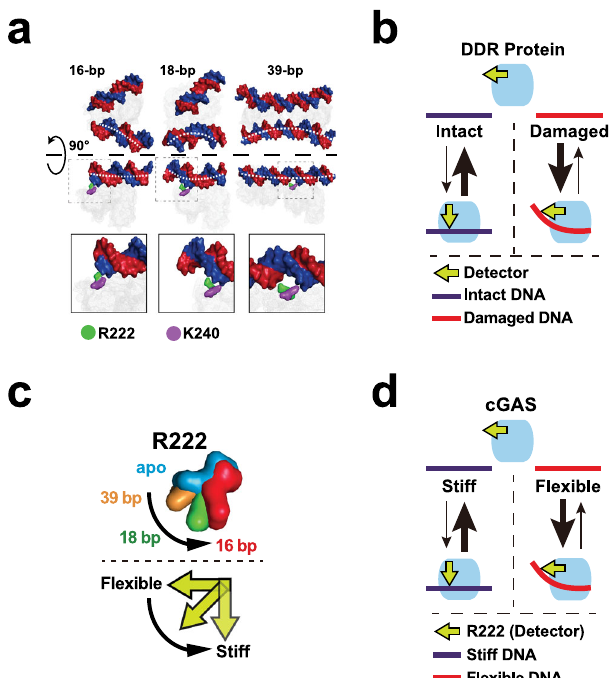
Fig. 1 | Schematic showing that DNA mechanical fl exibility controls cGAS activation. a Schematic showing that DNA strands are curved in the 16- (PDB 4K96), 18- (PDB 4LEZ), and 39bp (PDB 5N6I) DNA – cGAS atomic models. Notably, the conformation of cGAS R222 DNA-binding residue is considerably changed. R222 and K240 bind the same single strand of DNA (blue strand) in 18- and 16bp atomic models, while R222 and K240 separately bind the distinct single strands of DNA in 39bp atomic model. DNA and residues are shown by surface representa- tions.Blueandred:DNA;Green:R222;Purple:K240. b SchematicshowingthatDDR protein classically changes the conformation of detector to deform DNA to inte- grate DFC. It isenergeticallyunfavourable to curve the intact/stiff DNA. Hence, the intact/stiff and damaged/ fl exible DNAs form unstable and stable protein – DNA complexes, respectively. c Upper panel: Superposition analyses of R222 in apo (blue) (PDB 4K8V), 16- (red), 18- (green) and 39bp (orange) DNA – cGAS atomic models showing that the R222 conformation is changed with the DNA length. The sidechainofR222inapocGASatomicmodelisapproximatelyperpendiculartothe side chainofR222inthe 16 and 18bp DNA – cGASatomicmodels. R222isshownby surface models. Low panel: Schematic showing that the conformation of R222 (yellow arrow) might be changed with DNA- fl exibility, which is highly associated with DNA-length. d Schematic showing that, like DDR proteins described in ( b ), cGAS might change the conformation of R222 detector to integrate DFC. Con- sistently, cGAS binds the stiff and fl exible DNA to form the unstable and stable cGAS – DNA complexes,